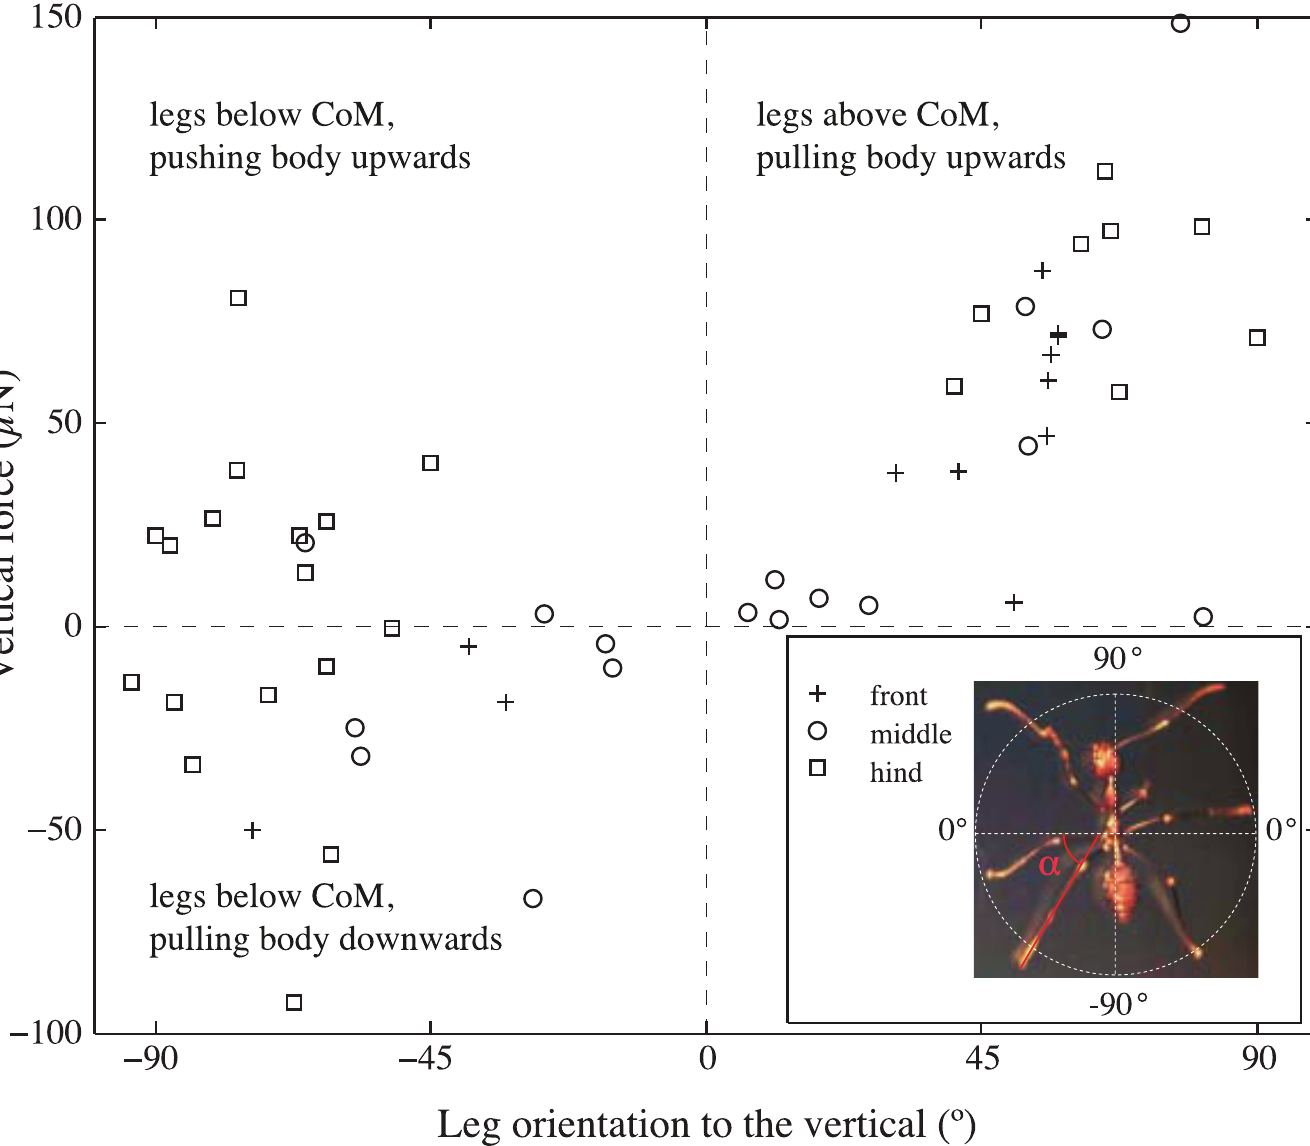
Fig 4. Single-leg vertical forces in weaver ants climbing on a vertical glass surface, as a function of leg orientation. Leg orientation is given as an angle ranging from -90° (pointing downward; N front = 3, N middle = 8, N hind = 18) to 0° (horizontal) to +90° (pointing upward; N front = 9, N middle = 10, N hind = 8). For all legs with negative angles, the foot position was below the CoM, and positive angles corresponded to foot positions above the CoM.